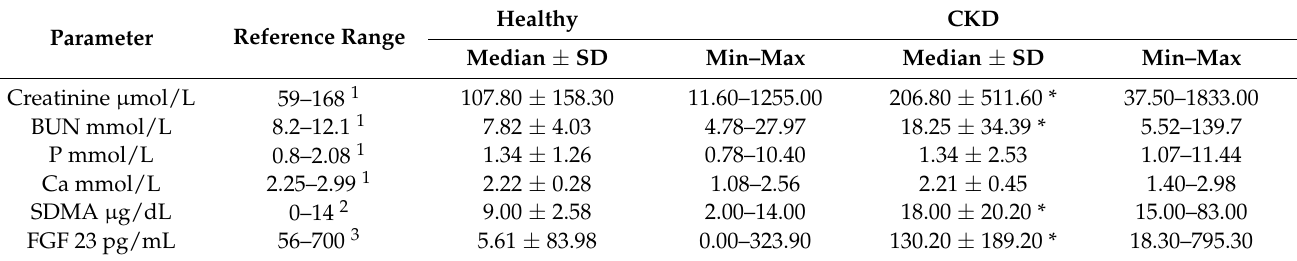
Table 1. Results of laboratory analysis of biochemical parameters.